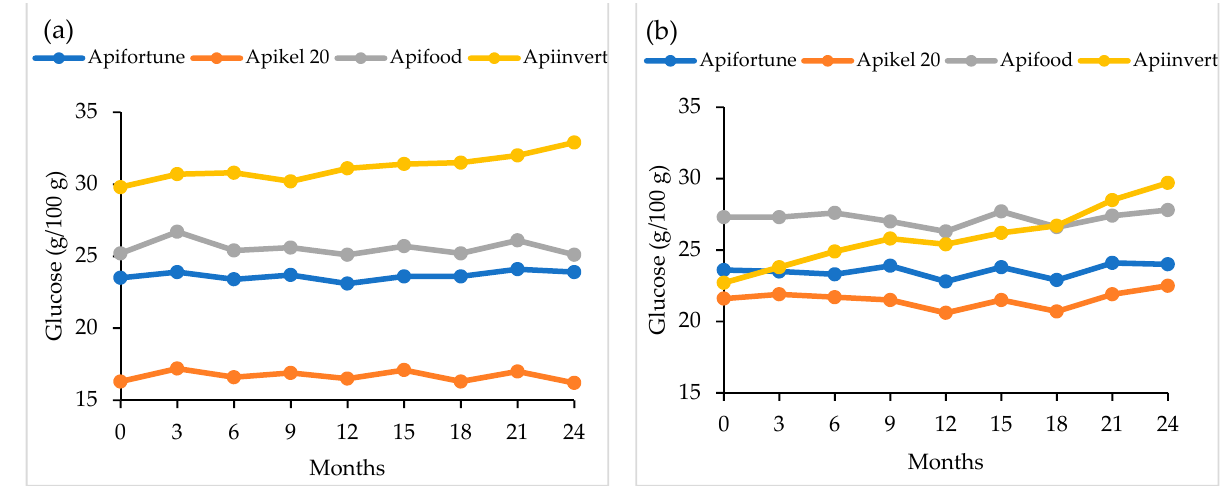
Figure 6. Changes of fructose content in syrups during storage at about 4 °C ( a ) from 2012 and ( b ) from 2013.